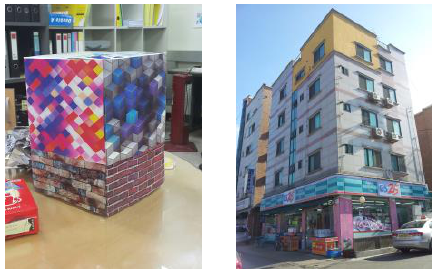
Figure 4. Artificial and Real buildings used in experiments